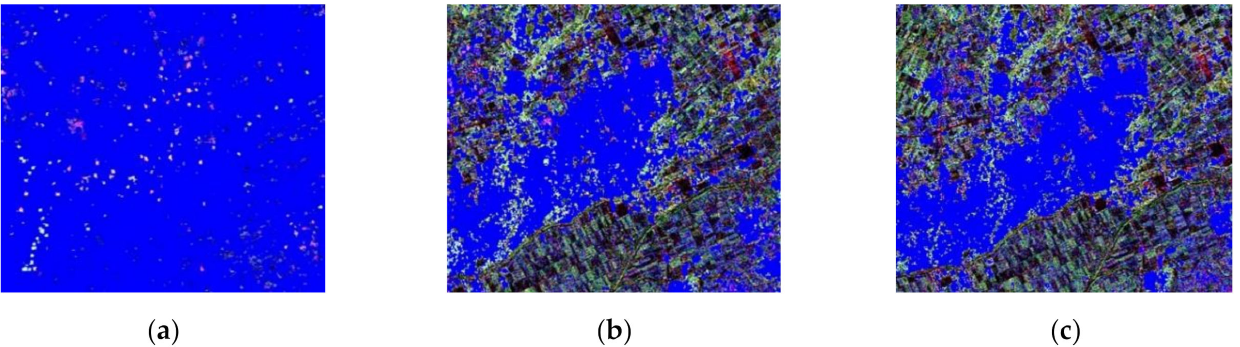
Figure 27. The results of non-building area removal in Mashiki town with different methods: ( a ) the H − α method; ( b ) the H − α − wishart classification method; ( c ) the proposed